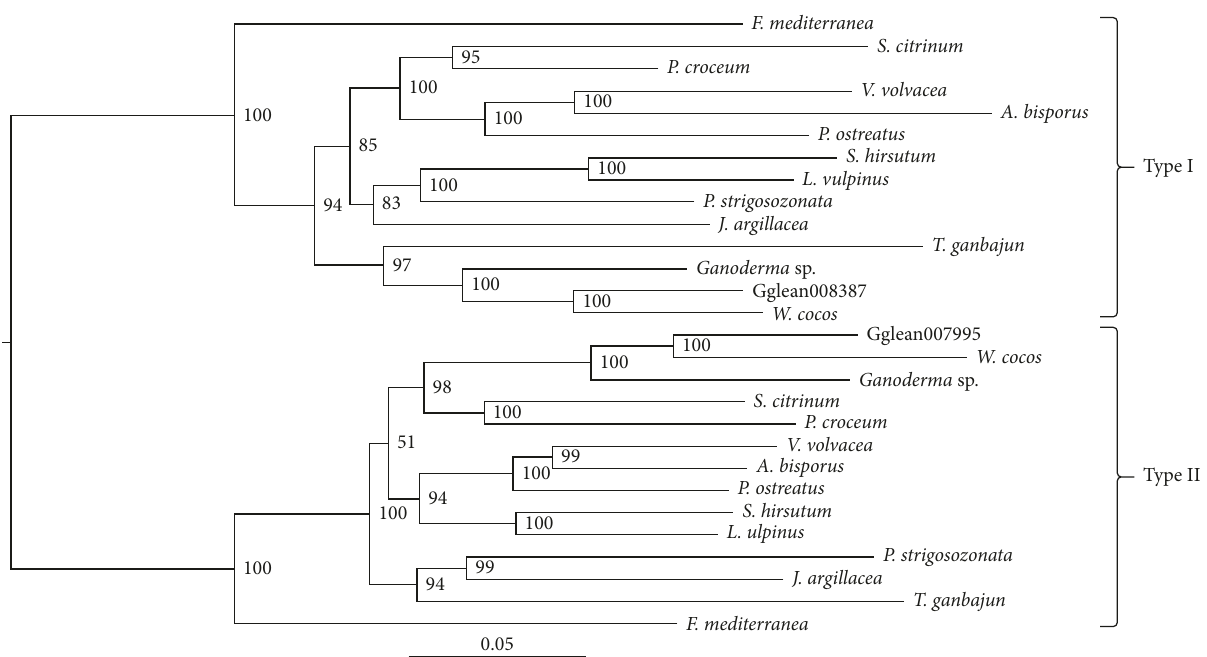
Figure 6: Analysis of -glucan synthases using protein sequences in the class Agaricomycetes. Protein accession of Fomitiporia β